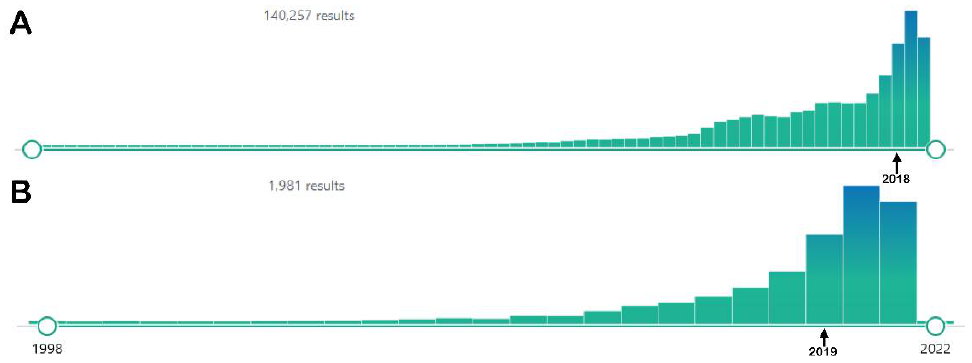
Figure 1. ( A ) Output of searching the term “artificial intelligence” on PubMed; ( B ) Output of searching the term “artificial intelligence” and “translational medicine on PubMed. The search was performed on 14 October 2021 (source PubMed https://pubmed.ncbi.nlm.nih.gov/; accessed on 14 October 2021).